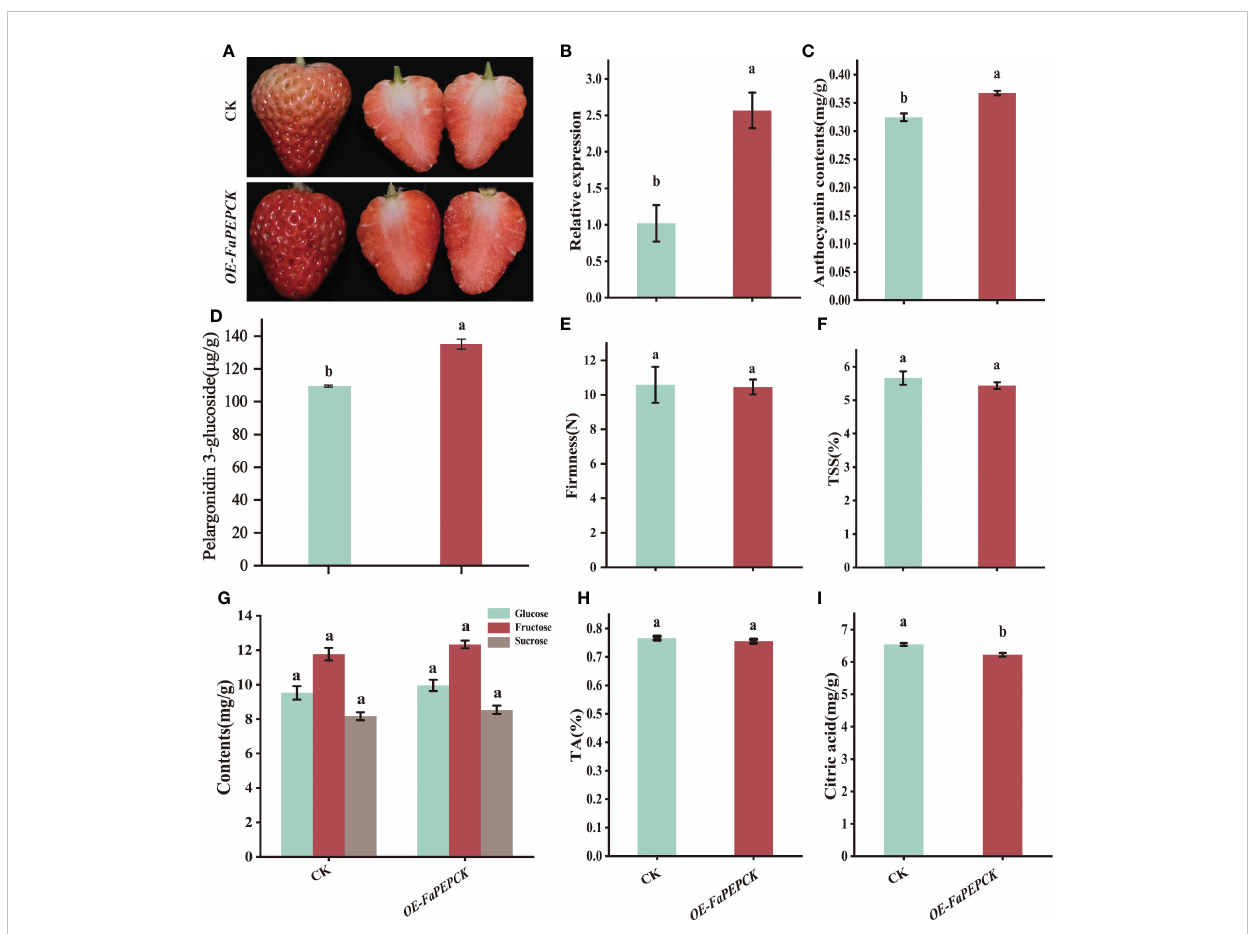
FIGURE 6 Overexpression of the FaPEPCK in strawberry fruits. The appearance of the treated fruits fi ve days after agrobacterium in fi ltration (A) , the relative expression level of FaPEPCK (B) , anthocyanin content (C) , pelargonidin 3-glucoside content (D) , fruit fi rmness (E) , total soluble solids content (TSS) (F) , glucose, fructose and sucrose content (G) , titratable acidity content (H) , citric acid content (I) . CK, the controlled fruit; OE- FaPEPCK , FaPEPCK - overexpressed